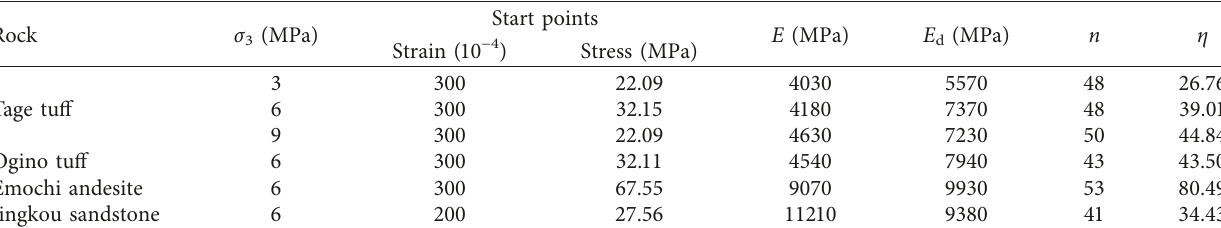
Figure 11: σ d vs stress in the postfailure region under (a) air-dried, (b) wet conditions. △ Table 5: Values of